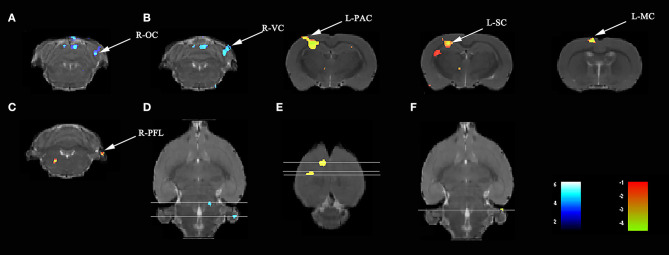
SS-31 treatment induced both short- and long-term functional connectivity (FC) changes in the aged rat brain. (A) SS-31 treatment caused FC changes in 3 days. SS-31 treatment improved FC connectivity in (B) 7 days and (C) 31 days. (D–F) Localization for different regions of interest (ROIs) on day 3, 7, and 31. Data were analyzed by one-way ANOVA followed by the post-hoc two-sample t-test. A voxel-level height threshold of p < 0.001 and a cluster-extent threshold of 20 were considered as statistically significant. Both the left and right hippocampus were used as seed voxels.